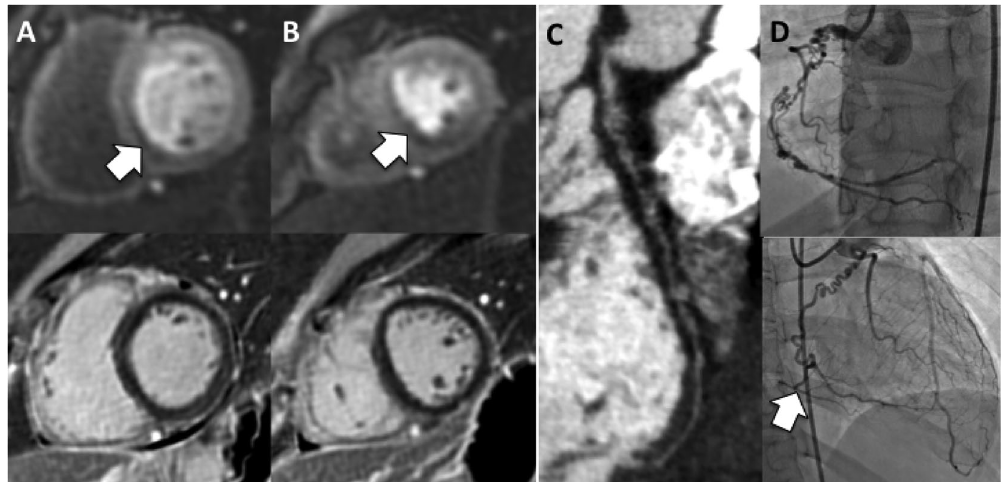
Figure4.StressperfusionCMRinthecontextofcollateralization. A,B)Azoneofsubendocardialhypoperfusionis evident in the RCA territory (arrows, top panels). Note the lack of underlying scar on the corresponding LGE